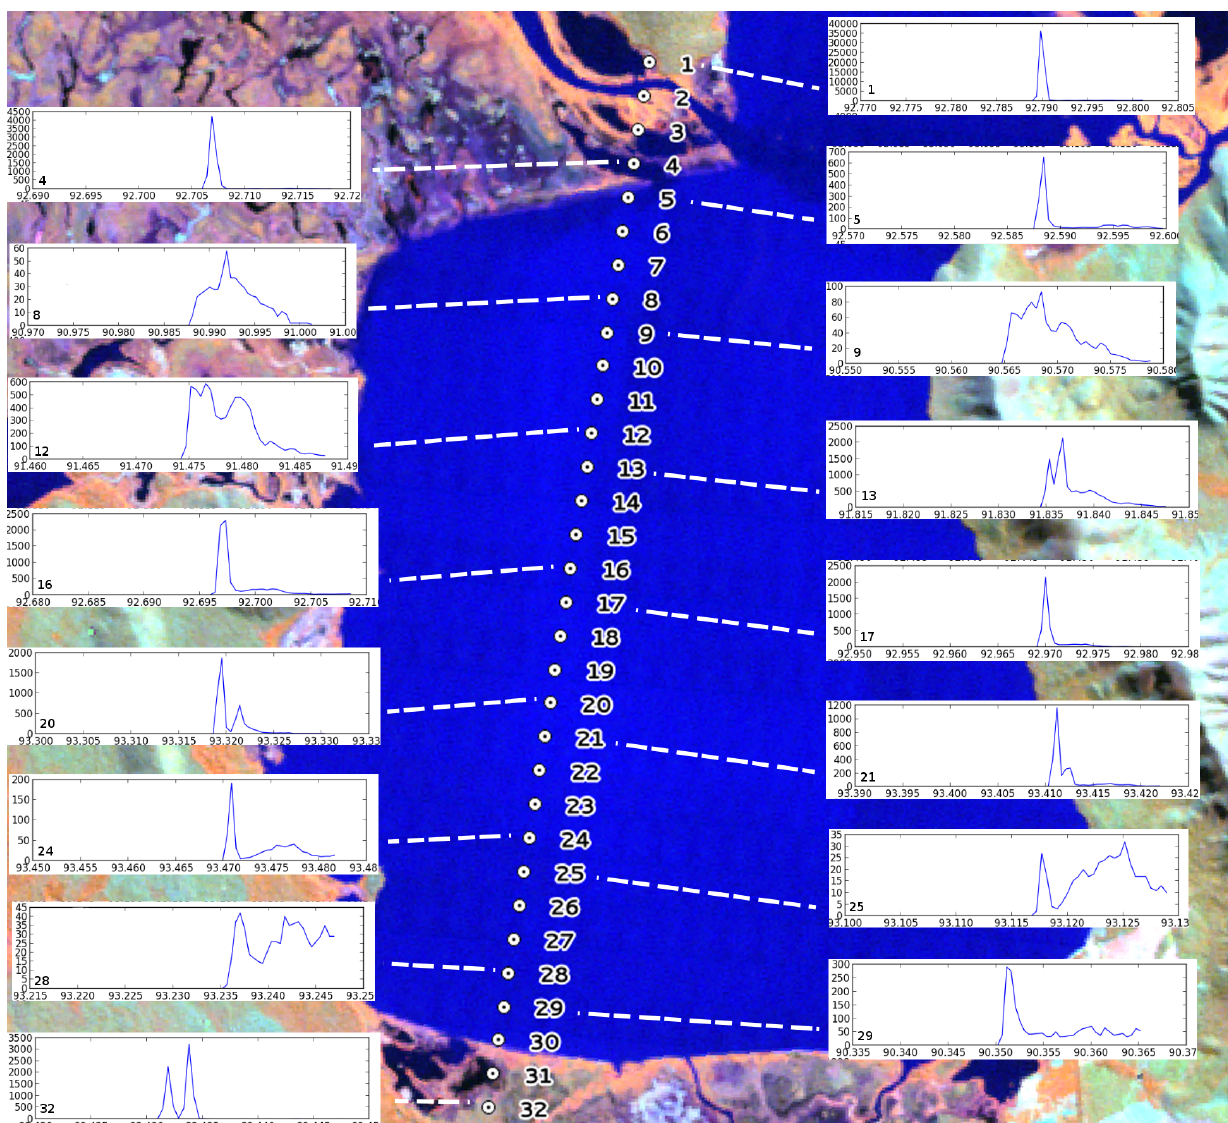
Figure 3: Illustration and interpretation of waveform response across Lake Gaiba. Waveforms 1, and 4 have both a very strong single peak return that might be produced by a roughly textured yet flat surface (vegetation) and the fact that water is present but off-nadir might cause that part of the impulse to be reflected specularly away from the sensor. Waveforms 5, 16, and 17 have a typical calm water response with a single peak of much less energy than the previous two and apparently receive very little influence from other surfaces. Waveforms 13, 20, 21 and 24 have a secondary peak (or peaks) that may come from the nearby land ( ≈ 2 km ) or even small waves that backscatter towards the antenna. Waveforms 8, 9, 12, 25, 28 and 29 are complex waveforms that receive influence from the land, waves or both; these waveforms may receive land contamination from more than one direction contributing to their complex shape. Waveform 32 has land at its nadir but clearly receives influence from off-nadir surfaces explaining why its peaks corresponds to altitudes below the lake surface. Note the small range near the Eastern shore of the